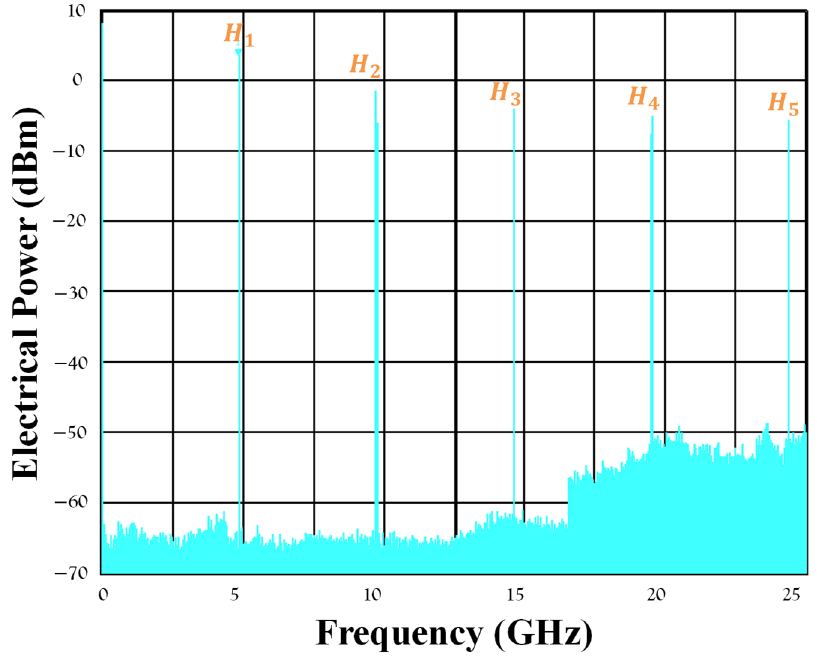
Figure 3. The OPS harmonics obtained through an ESA at a 5 GHz repetition rate at the incoming port of the employed SOA-MZI.